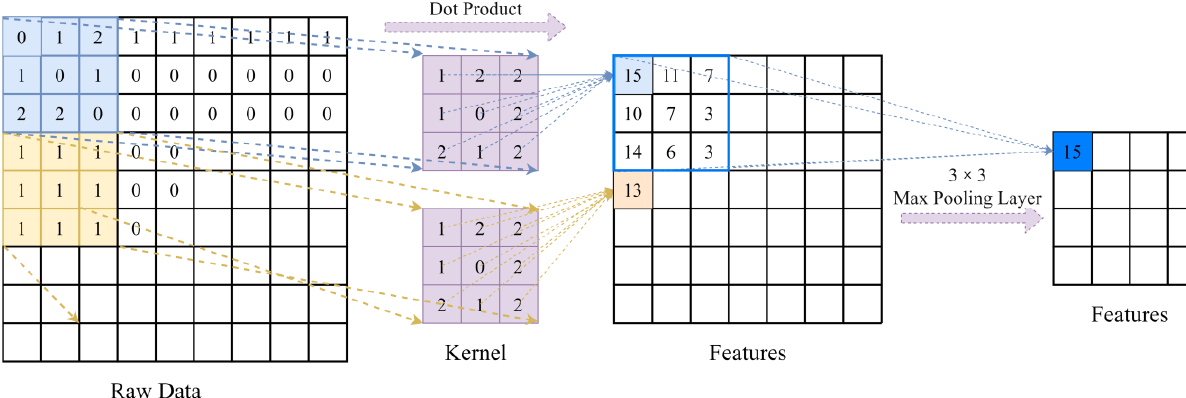
Figure 4. The process of convolutional